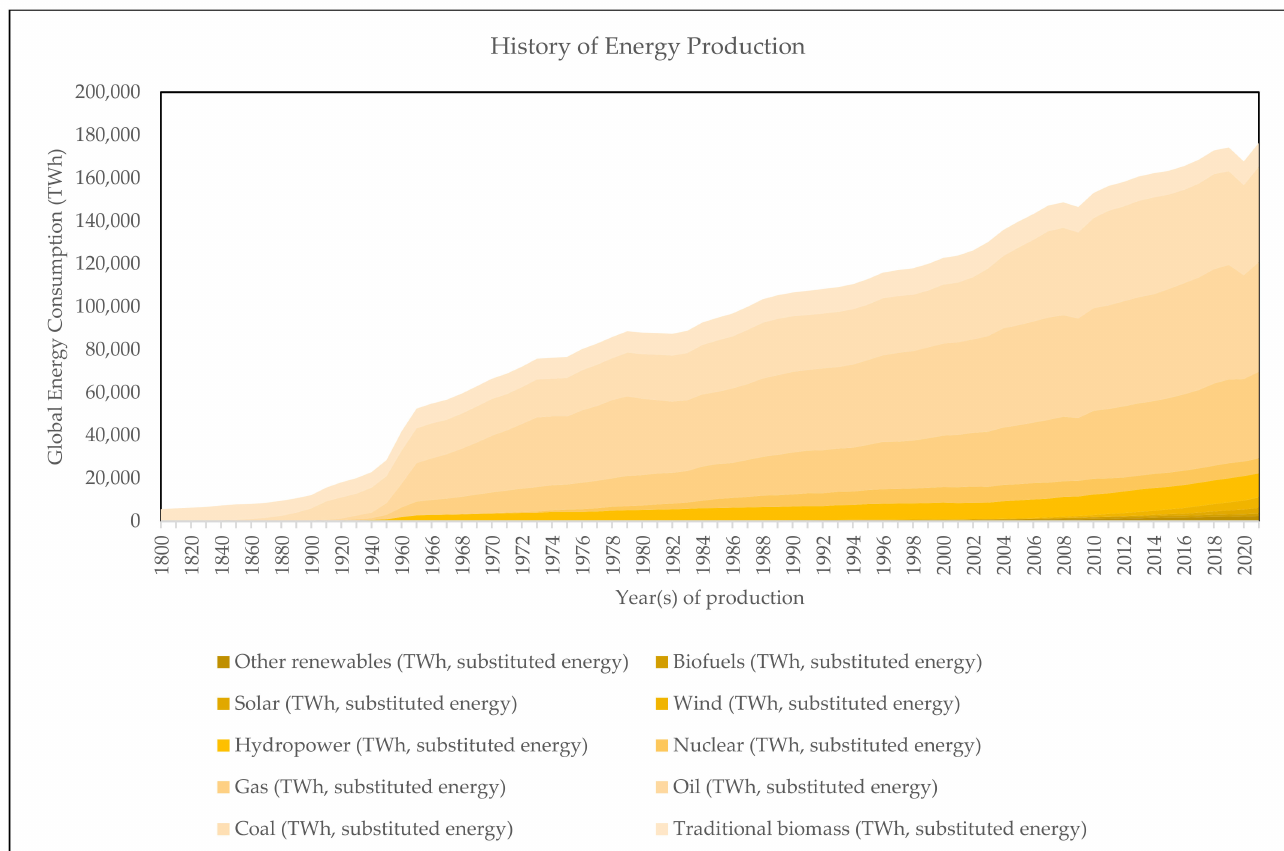
Figure 1. Global energy consumption (TWh) measured from varied energy sources over the past. (The graph was redrawn using data that are publicly made available for open source usage and proper citation is added to this